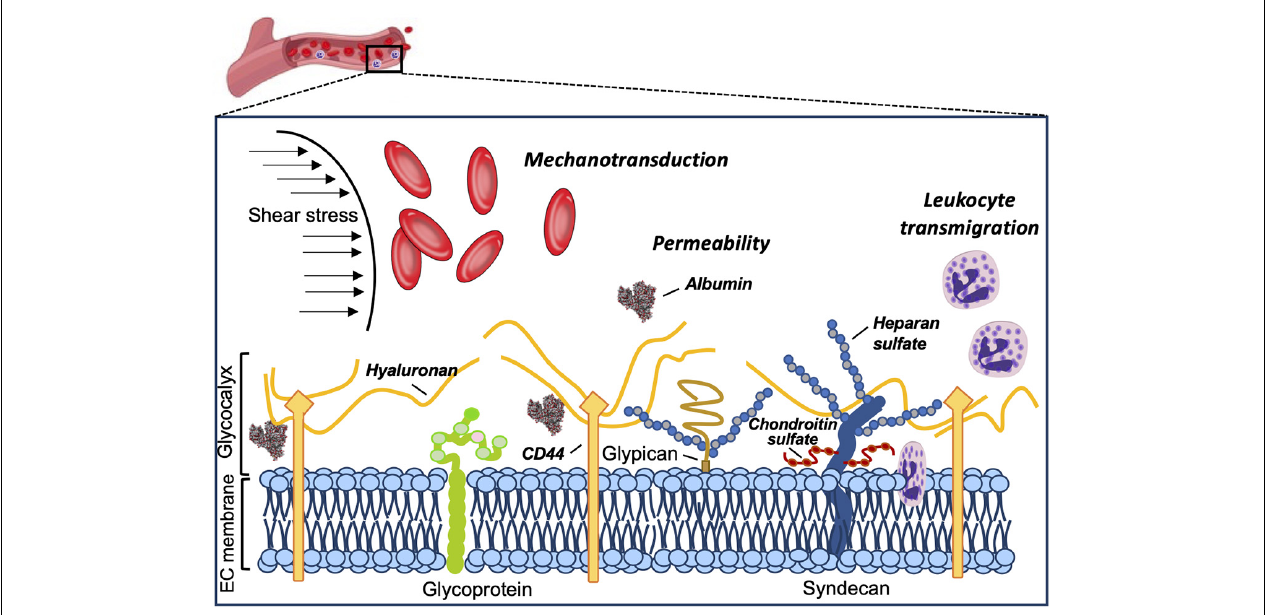
FIGURE 1 | Structure and functions of the eGCX. Schematic representation of the main components and functions of the endothelial glycocalyx. The eGCX is composed of proteoglycans, with long glycosaminoglycan side-chains (GAG-chain) and glycoproteins, with short branched carbohydrate side-chains. The eGCX modulates coagulation, inflammation and mechanotransduction